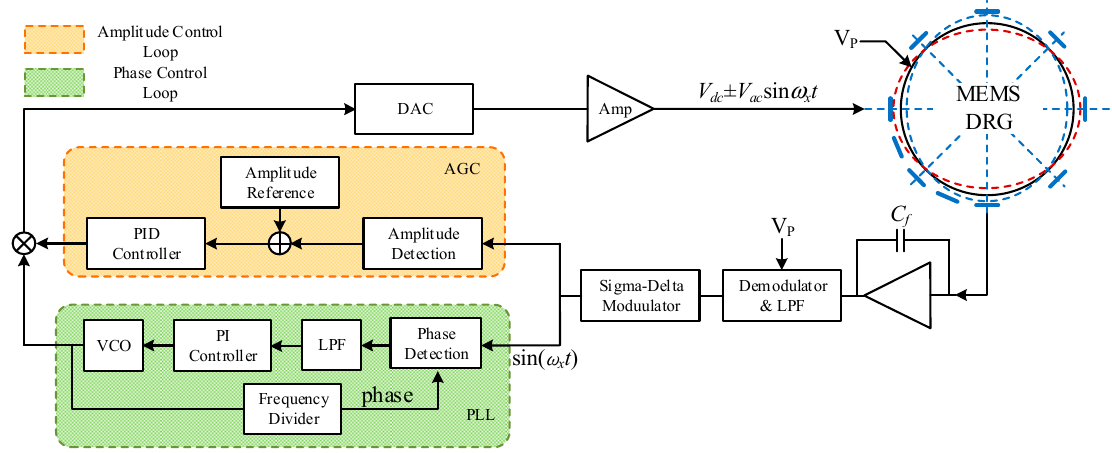
Figure 5. Schematic diagram of the frequency control loop and the amplitude control loop.